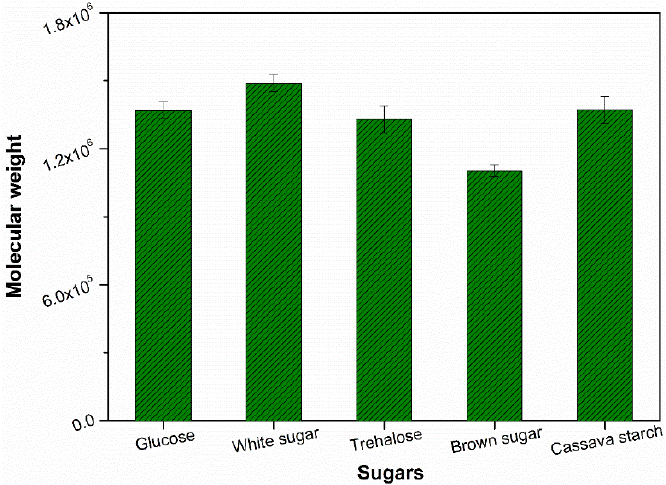
Figure 1. Effect of sugars used for coagulation on the molecular weight of resulting natural rubber. To further confirm the ability of sugar to decompose the protein and phospholipids,